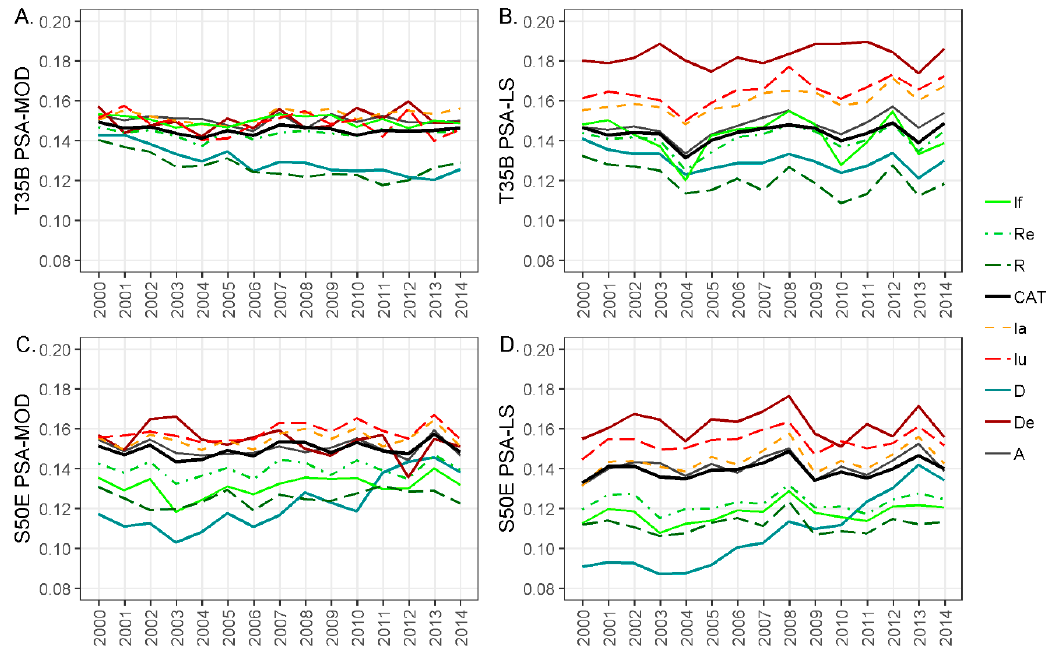
Figure 7. PSA in transition classes over the study period (If-woody encroachment, Re- reclamation, R-afforestation, CAT-catchment average, Ia-increased cultivation, Iu-increased urban, D-deforestation, De-degradation, A-abandonment).